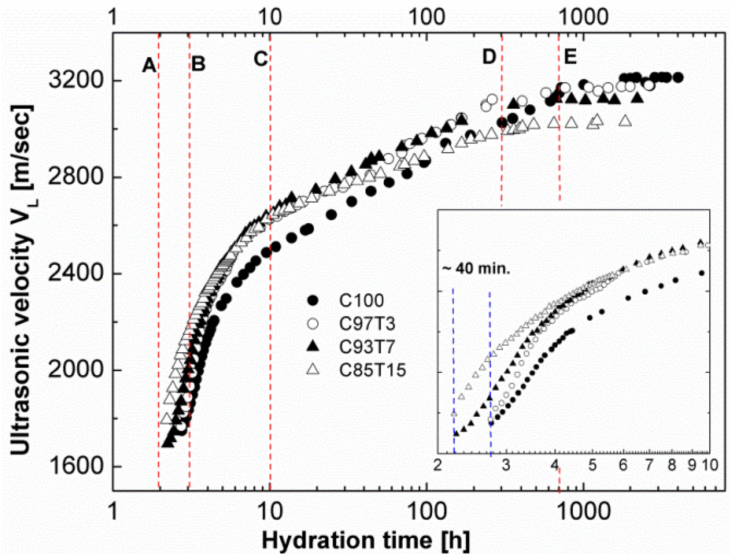
Figure 3. Ultrasonic longitudinal velocity versus hydration time for the samples used in this study. The inset presents the data during the first ten hours of hydration time. The vertical dashed lines are presented for clarification and to indicate the di ff erent hydration periods as discussed within the